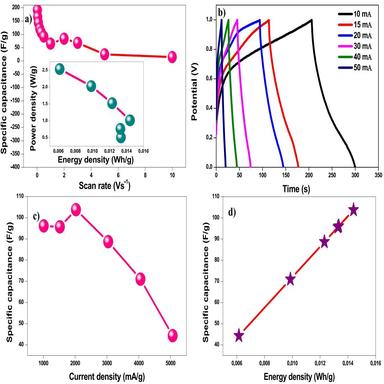
Properties of IL-β-MNV - based super capacitor: a) variation of the specific capacitance with scan rate, Inset: Ragone diagram b) charge/discharge V-T curves c) rate capability (specific capacitance vs. current density) d) specific capacitance vs. energy density.